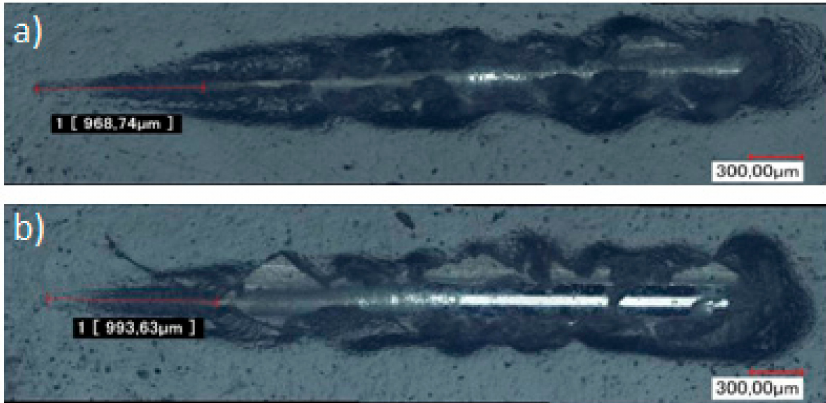
Figure 13. Optical micrographs of microscratch performed on ( a ) phosphated zinc + TEOS/MAP + paint; and ( b ) phosphated zinc + TEOS/(50%MAP + 50%UPS) +